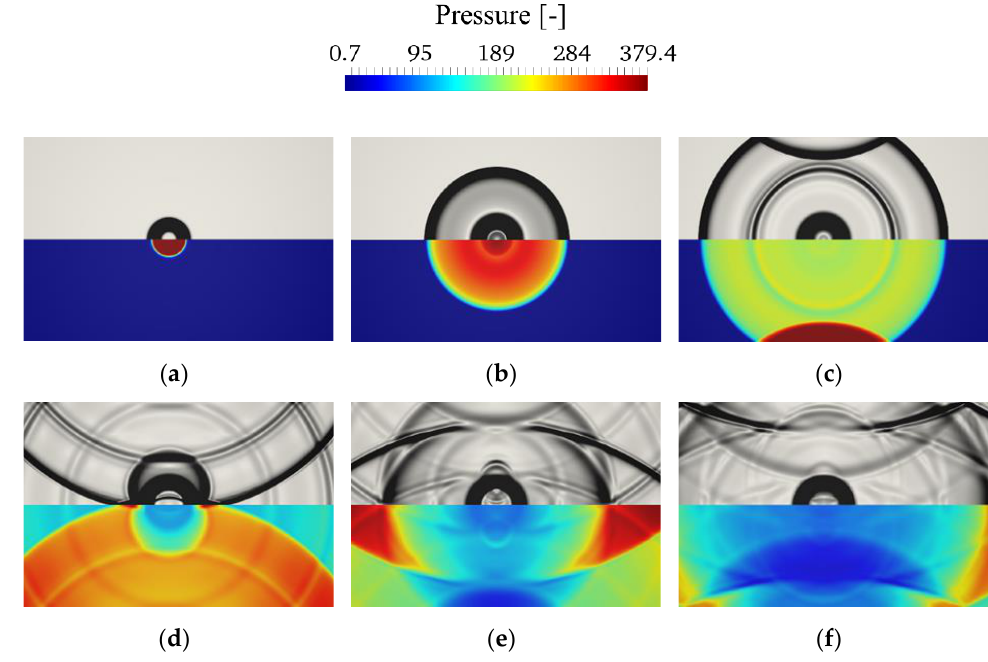
Figure 7. Pressure field evolution generated by the single laser-induced bubble at ( a ) t = 0.0, ( b ) t = 0.9, ( c ) t = 1.8, ( d ) t = 3.3, ( e ) t = 4.5, and ( f ) t = 5.4; numerical schlieren at the upper side and pressure distribution at the lower side of each figure.